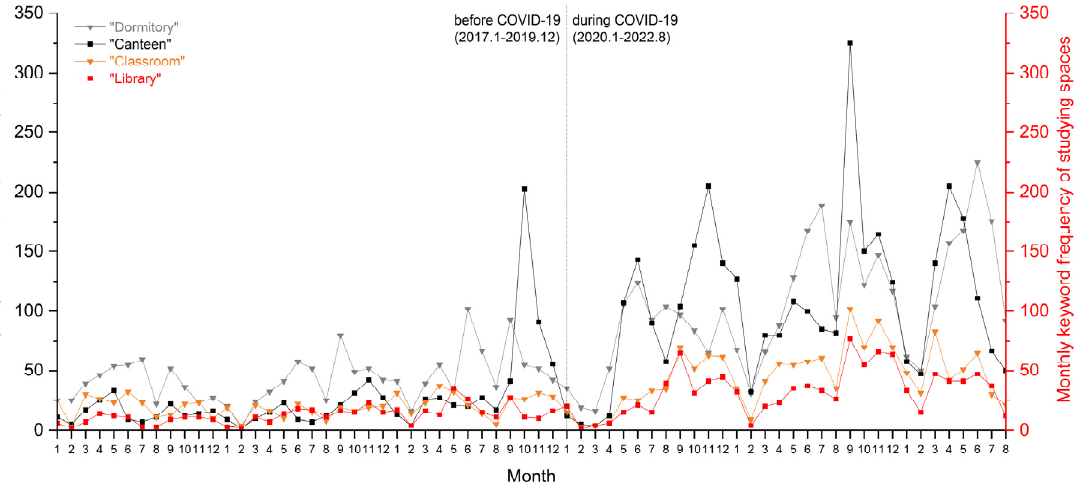
Figure 7. Monthly keyword frequency: “Dormitory”, “Canteen”, “Classroom”, and “Library”.